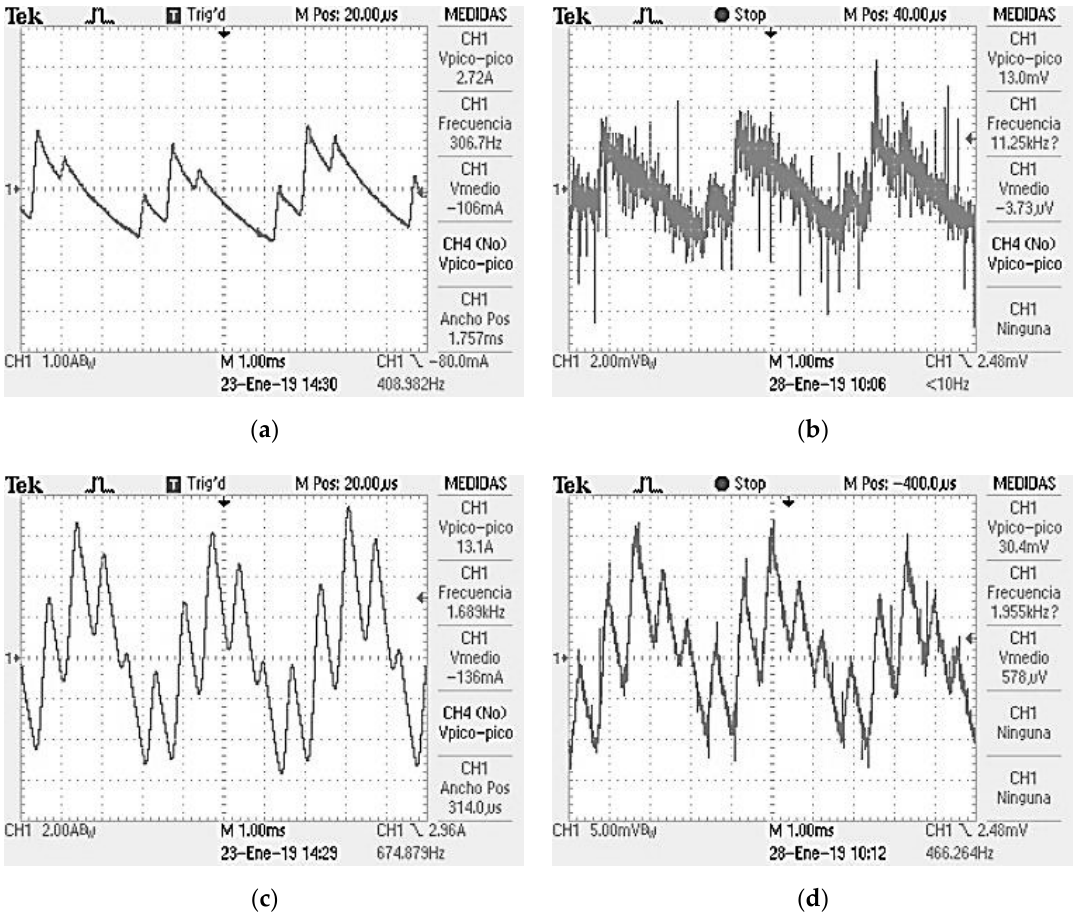
Figure 2. Current and voltage ripple measurements. ( a ) Battery current ripple at low load (1 A/Div. and 1 ms/Div.); ( b ) one ‐ cell voltage ripple at low load (2 mV/Div. and 1 ms/Div.); ( c ) battery current ripple at full load (2 A/Div. and 1 ms/Div.); ( d ) one ‐ cell voltage ripple at full load (5 mV/Div. and 1 ms/Div.).